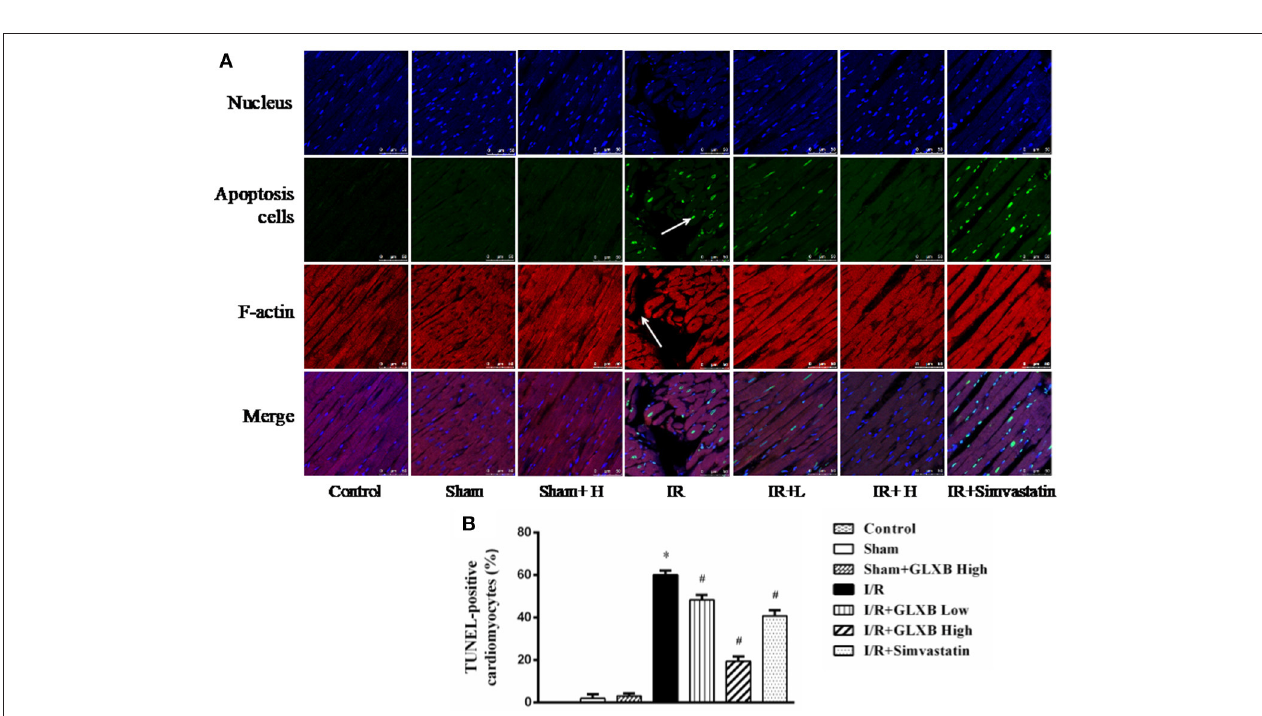
FIGURE 8 | The effect of GLXB on myocardial apoptosis. (A) Representative photographs of double staining of TUNEL and F-actin (40 × ). Nucleus are stained with blue, F-actin red, and TUNEL-positive cells green. Bar = 50 µ m. (B) Quantitative analysis of apoptosis cells in the various groups. Data are mean ± SEM, n = 6. * P < 0.05 vs. Sham group, # P < 0.05 vs. I/R